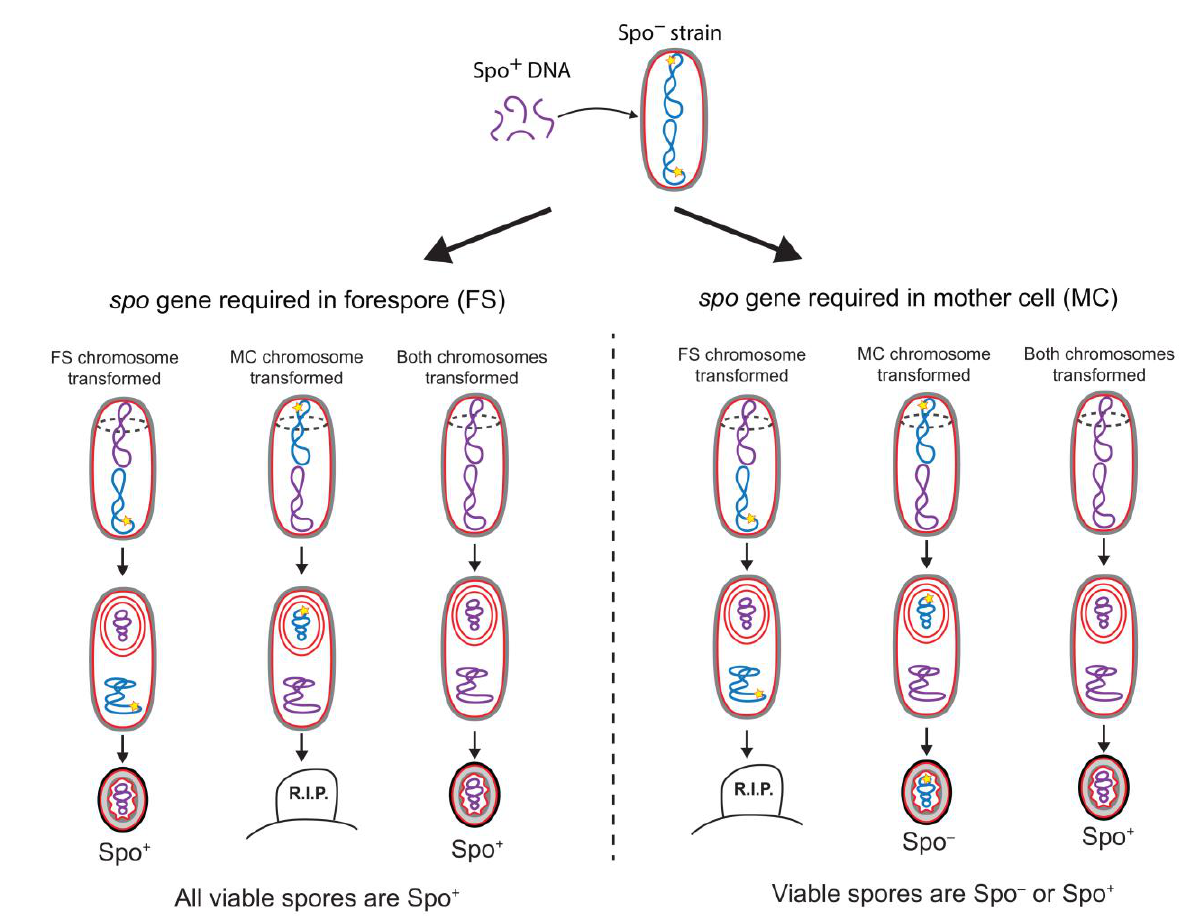
FIGURE 4: Genetic strategy to identify the cell in which a spo gene is required. A Spo – strain with a mutation in a known spo gene (yellow star) is depicted in Stage I (see Fig. 2 ) with its two chromosomes, one that will be packed into the forespore (upper chromosome) and one that will remain in the mother cell and be destroyed when the mother cell lyses (lower chromosome). The strain is transformed with ge- nomic DNA from a Spo + strain at the onset of sporulation. Transformed chromosomes are drawn in purple, non-transformed chromosomes, in blue. Either or both chromosomes are capable of being transformed to spo + . If the spo gene is required in the forespore ( left panel ), transformation of the forespore chromosome to spo + rescues the process and generates spores that can germinate and go on to sporulate again (left). But transformation of the mother-cell chromosome to spo + with no accompanying transformation of the forespore chromosome leaves the forespore chromosome spo – so the cells cannot complete the process, and no spores are produced (center). Hence only Spo + spores are generated if the spo gene is required in the forespore. If the spo gene is required in the mother cell ( right panel ), transformation of the mother-cell chromosome to spo + rescues the process (center and right), but only if the forespore chromosome is transformed as well will the spores that are produced be able to germinate into cells that can go on to sporulate again (right). Hence, both Spo + and Spo – spores can be generated if the spo gene is required in the mother